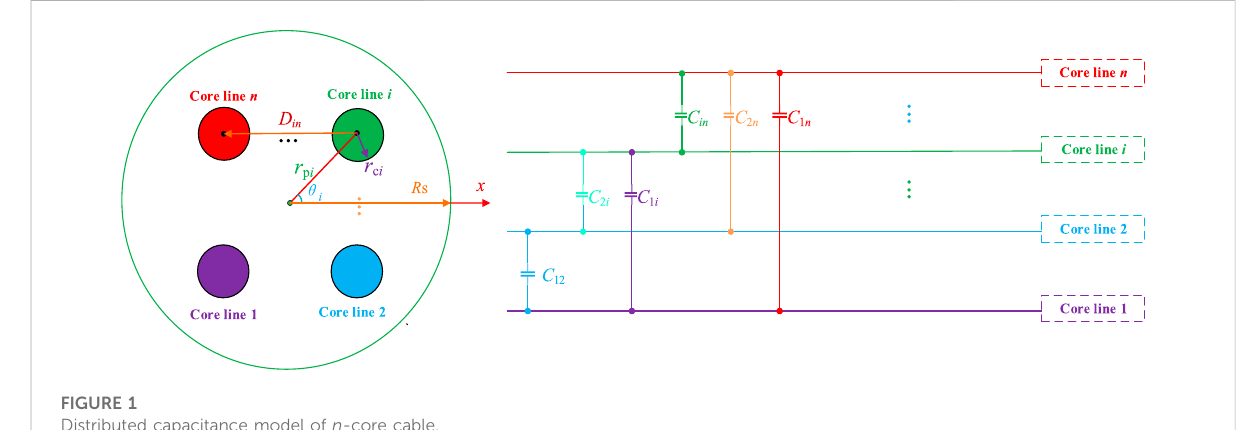
FIGURE 1 Distributed capacitance model of n -core cable.